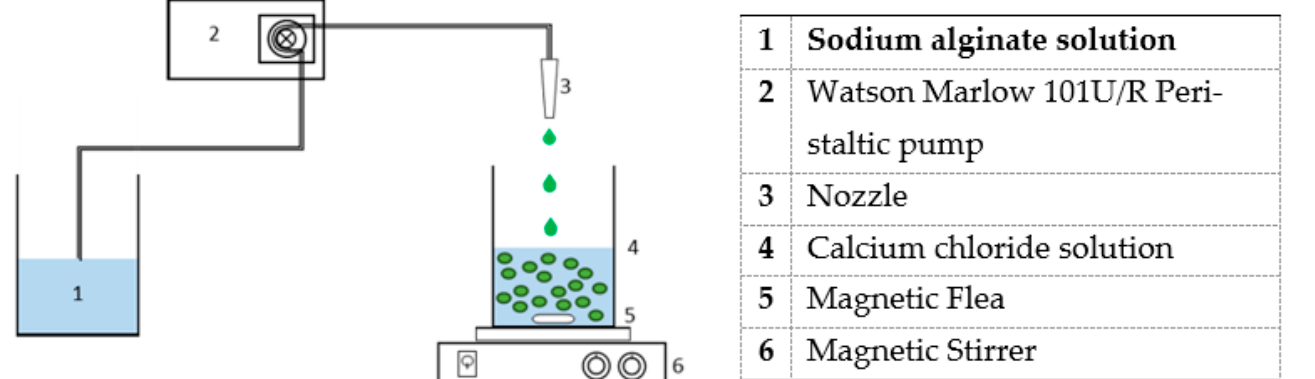
Figure 6. Schematic diagram illustrating the method used to produce alginate-based hydrogel